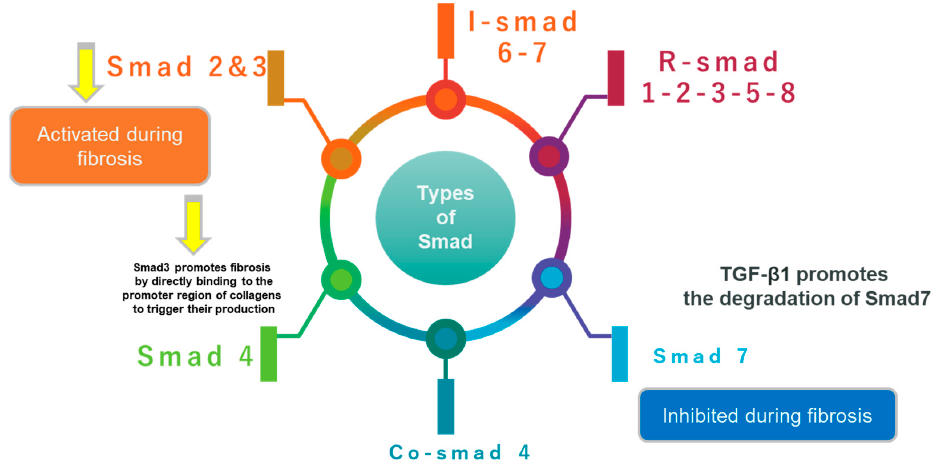
Figure 4. The schematic diagram illustrates the different types of Smad: receptor regulated Smad (R-Smad); common partner-Smad (co-Smad); and Inhibitory Smad (R-Smad); common partner-Smad (co-Smad); and Inhibitory Smad (I-Smad). 2.3. Role of Fibroblast Growth Factor23 (FGF23) in Fibrosis FGF23 is a 32 kDa proteohormone that belongs to the fibroblast growth factor (FGF) family [29]. The newly identified endocrine hormone FGF23 is produced by osteoblasts and osteoclasts in bone and affects the kidney and parathyroid glands to control phosphate homeostasis and vitamin D metabolism [30]. High levels of FGF23 have also been proven to have pathologic effects in addition to its physiological benefits. Studies